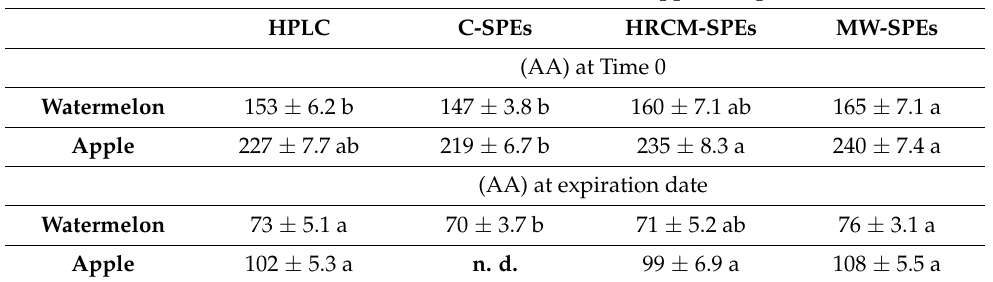
Table 2. AA concentration ( µ M) determined in the watermelon and apple samples at time 0 and at the expiration date with HPLC, C-SPEs, HRCM-SPEs functionalized with 5 mg/mL of HRCM/DMF suspension, and with MW-SPEs functionalized with 10 mg/mL of MWCNT/DMF suspension. AA Concentration ( µ M) in Watermelon and Apple